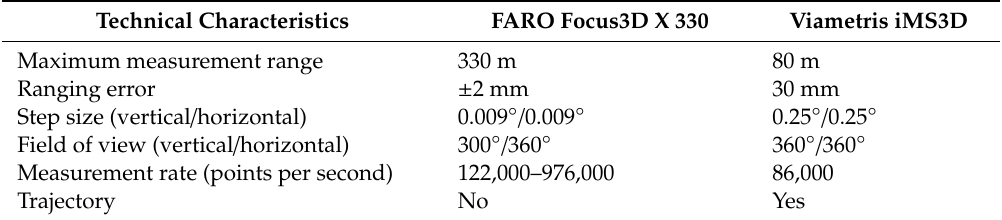
Table 1. Technical characteristics of the FARO Focus3D X 330 and Viametris iMS3D according to the manufacturer